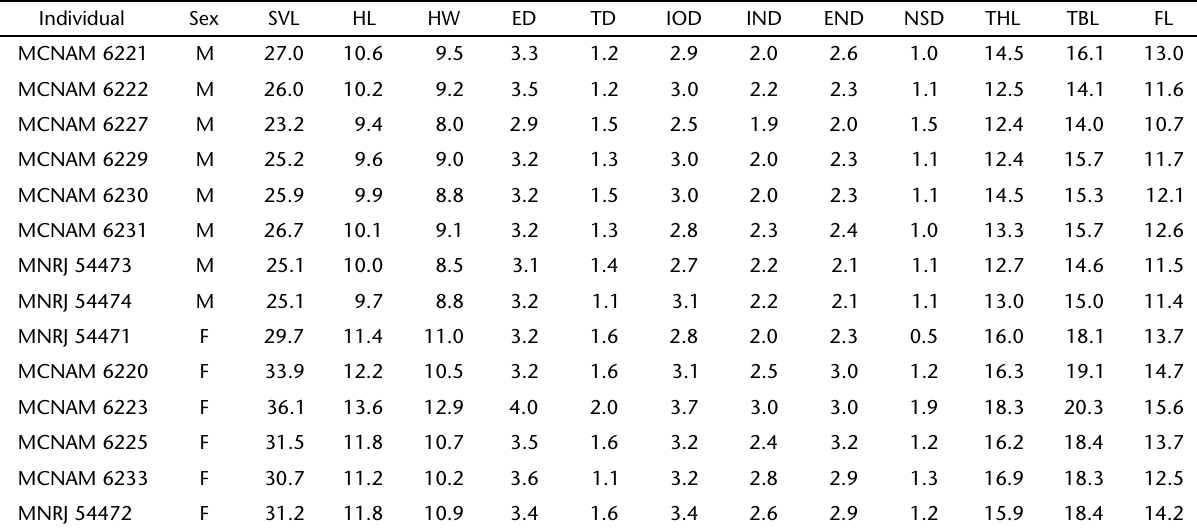
Table I. Measurements (mm) of holotype (MNRJ 54474) and paratypes of S. skaios sp. nov. (M) male and (F) female.